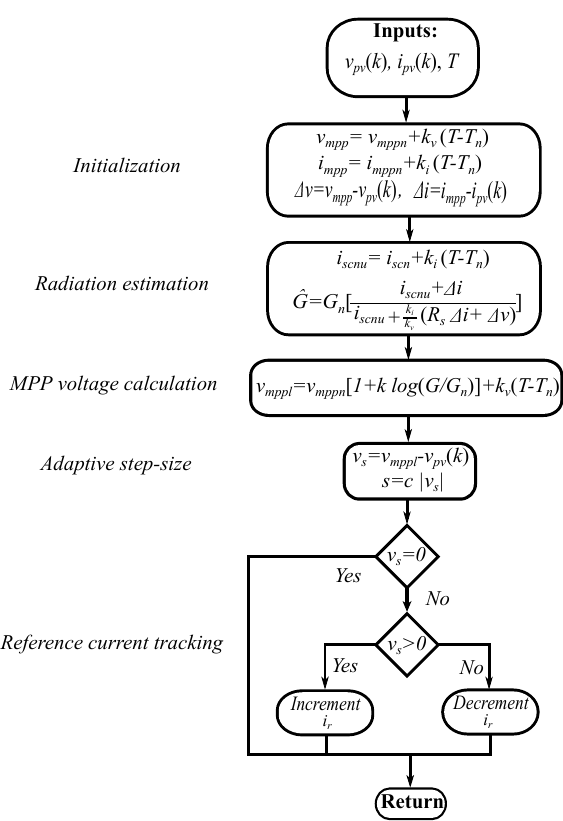
Figure 11. The proposed adaptive model-based MPPT